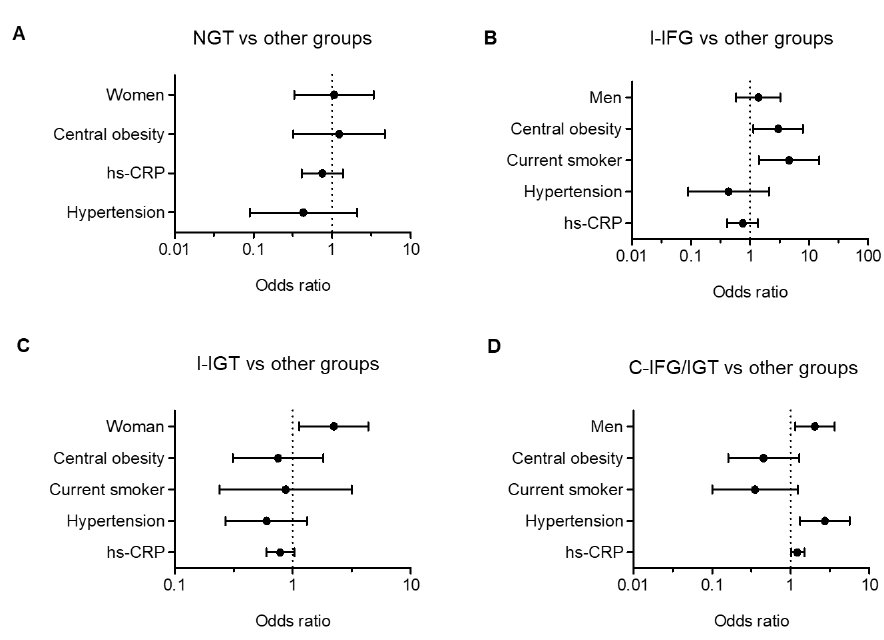
Figure 3. Logistic regression between ( A ) NGT vs .other prediabetes groups, ( B ) I-IFG vs. other prediabetes groups, ( C ) I-IGT vs. other prediabetes groups, and ( D ) C-IFG / IGT vs. other prediabetes